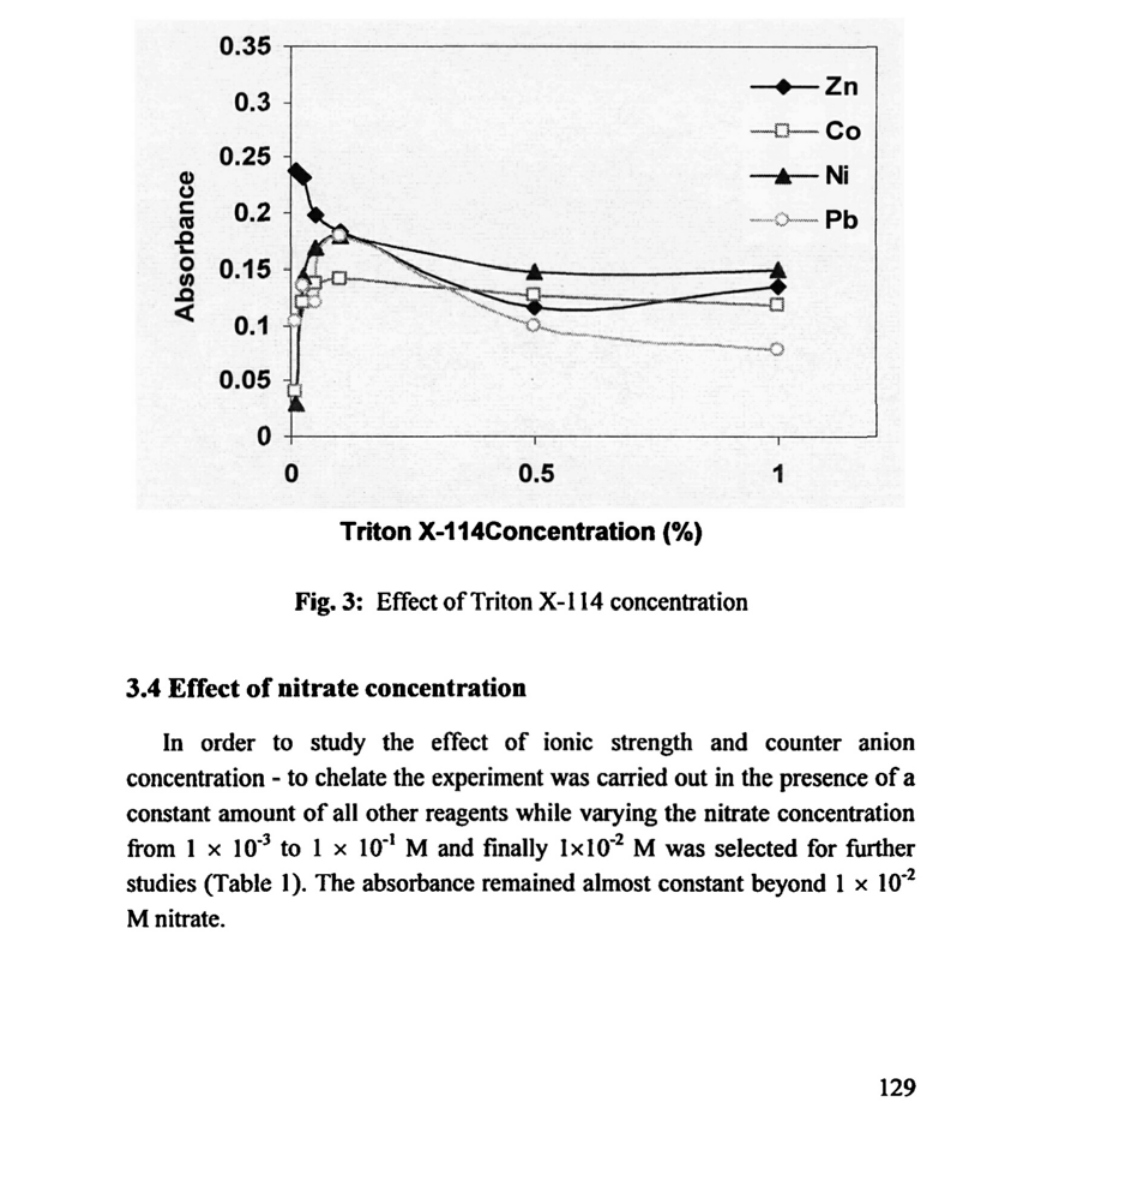
Fig. 3: Effect of Triton X-l 14